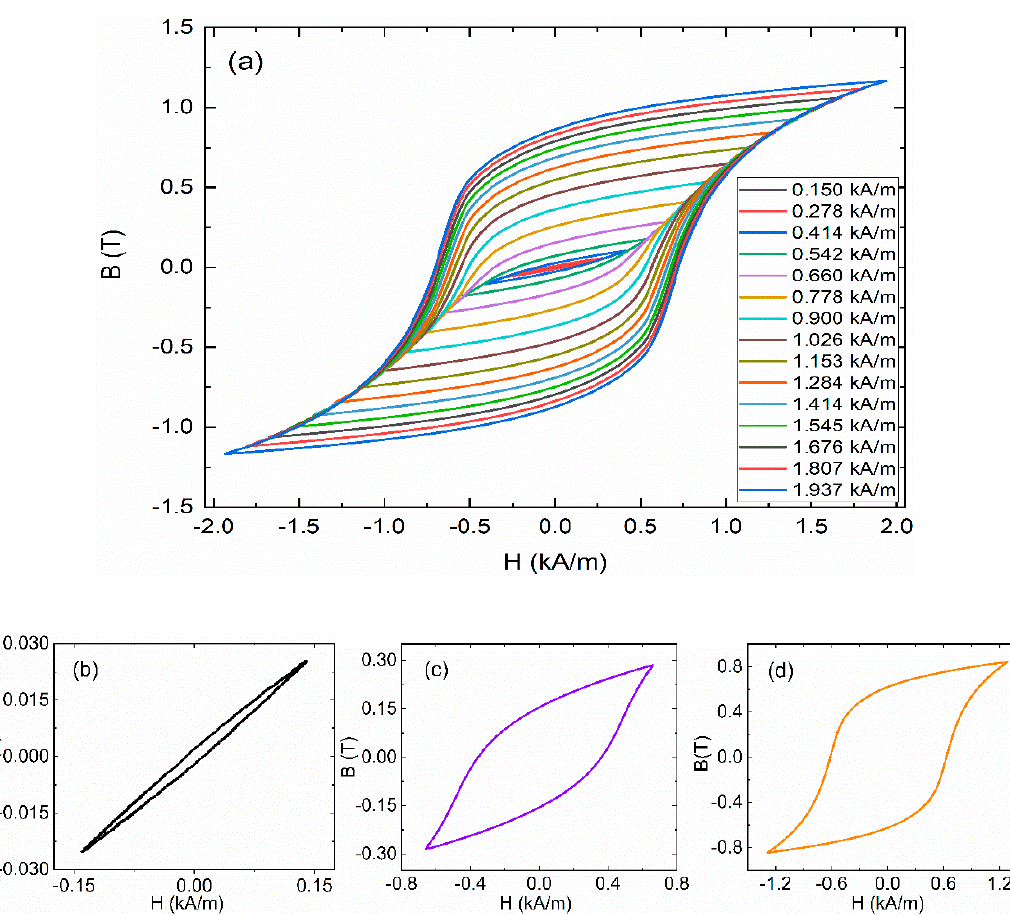
Figure 6. ( a ) A series of minor loops with the amplitudes ranging from 150 to 2000 (A/m) for the DP600CR 1.4 mm sample. The magnetic field amplitude influences the shape of the minor loops, a lenticular shape at a small field amplitude ( b ) and ( c ) at a higher field amplitude it shows a sigmoid shape ( d ).